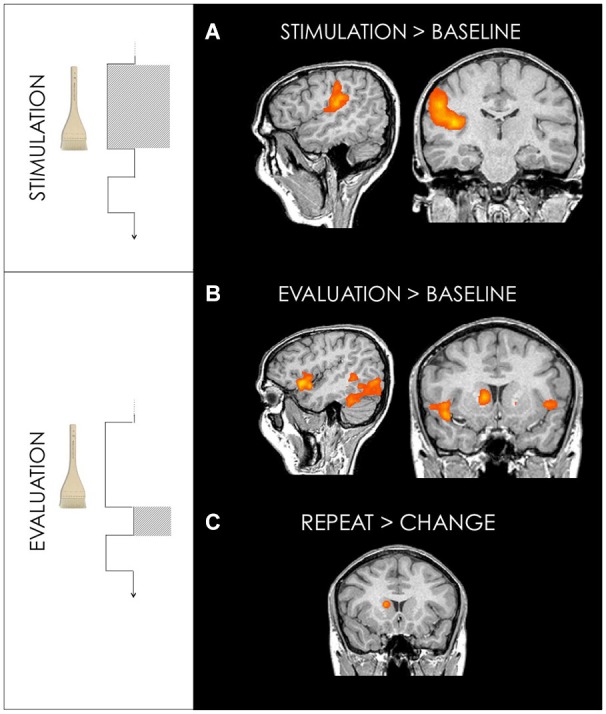
(A) Activation maps for GLM1: Stimulation. Brush stroking stimulation revealed activations in somatosensory areas. Right primary somatosensory cortex (29, −38, 54) and secondary somatosensory cortex/posterior insula (38, −14, 12) for stimulation on both arm and palm are shown. (B) Activation maps for GLM2: Evaluation Stimulation (Table 2). This interval reflects the 1 s following the stimulation before choice. Bilateral anterior insula (44, 19, −3 and −43, 19, −3) and primary visual cortex (11, −80, 6) are shown. (C) The repeat vs. change contrast, revealed activation in the right caudate (14, 13, 15). Random effect contrasts were performed at a corrected threshold of p < 0.001. Talairach coordinates, radiological convention (left is right).